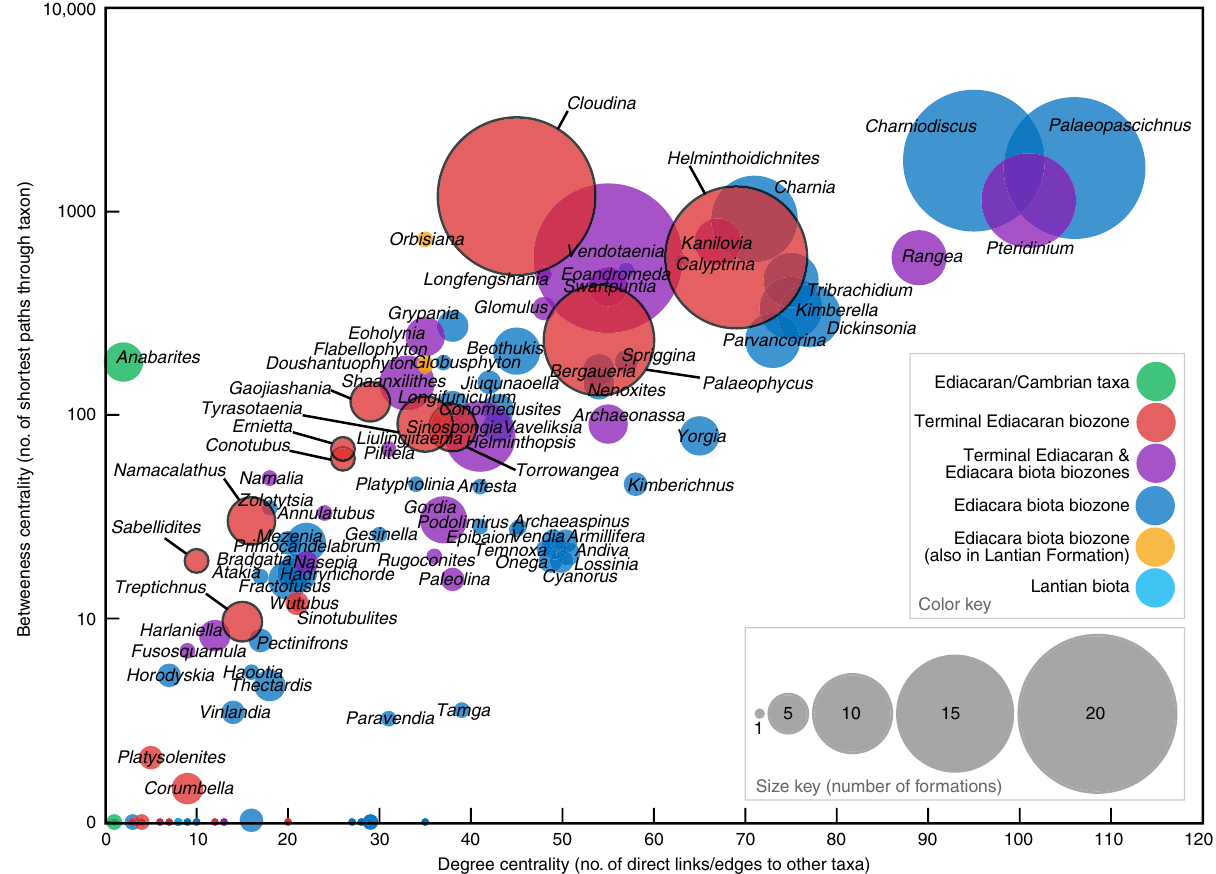
Fig. 6 Bubble plot showing network centrality scores for stratigraphic index fossils. Each bubble represents an Ediacaran macrofossil genus or ichnogenus in the bipartite network of Ediacaran formations and taxa (Fig. 4). Their colors correspond to biozones in that network (Fig. 4a, b). The diameter of each bubble equals the number of formations that contain fossils of the taxon. The x - and y -axes are node centrality scores. A node ’ s centrality score indicates its relative importance within a network. These scores were calculated from the taxa projection of the bipartite network based on two different de fi nitions of centrality. The x -axis is degree centrality (or simply degree), which is the number of unique links between the taxon and any other. The scores in this plot do not re fl ect self-loops (i.e., connections between nodes and themselves). Whereas taxa with high degree centrality cooccur with a multitude of others, those with low scores cooccur with relatively few. The y -axis is betweenness centrality, which equals the number of shortest paths that pass through the node in its network. Whereas taxa with low betweenness centrality scores tend to be located at the beginning and end of paths, those with high scores commonly act as bridges for the fl ow of information. With regard to this plot, the best index fossils are red or blue (i.e., closely associated with one biozone) and have large bubbles and high centrality scores because they are geologically widespread and relatively common. Notable Terminal Ediacaran index fossils have black borders. Source data are provided as a Source Data fi